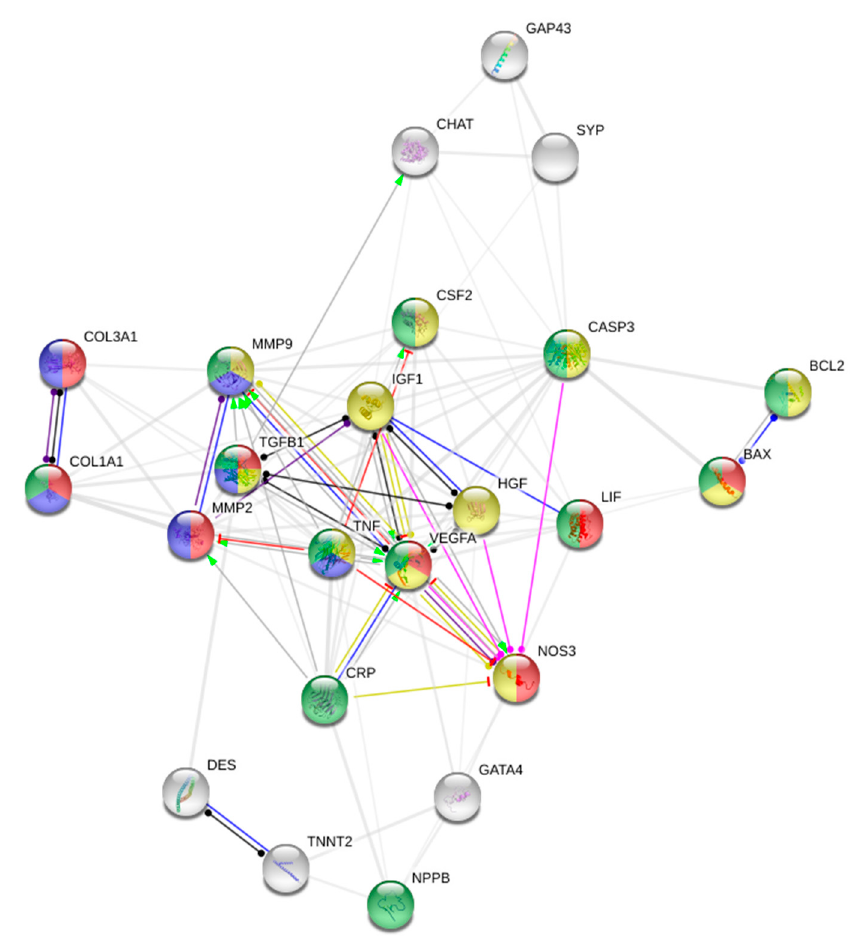
Figure 5. The PPI network. Red are proteins involved in blood vessel development, purple ECM organization, green regulation of immune system processes and yellow apoptosis. Red interaction lines illustrate inhibition, green activation, pink post-translational modification, blue binding, purple catalysis, yellow transcriptional regulation, and black reaction. Abbreviations; Transcription factor GATA-4 (GATA4), Brain natriuretic peptide (NPPB), Growth Associated Protein 43 (GAP43), Cholineacetyltransferase (CHAT), Synaptophysin (SYN), Leukocyte inhibitory factor (LIF), Granulocyte-macrophage colony-stimulating factor (CSF2), Insulin-like growth factor-1 (IGF-1), Troponin T (TNNT2), Collagen Type III Alpha 1 Chain (Col3a1), Collagen Type 1 Alpha 1 Chain (Col1a1), Endothelial NOS (NOS3), C-reactive protein (CRP), Caspase 3 (CASP3), Desmin (Des).